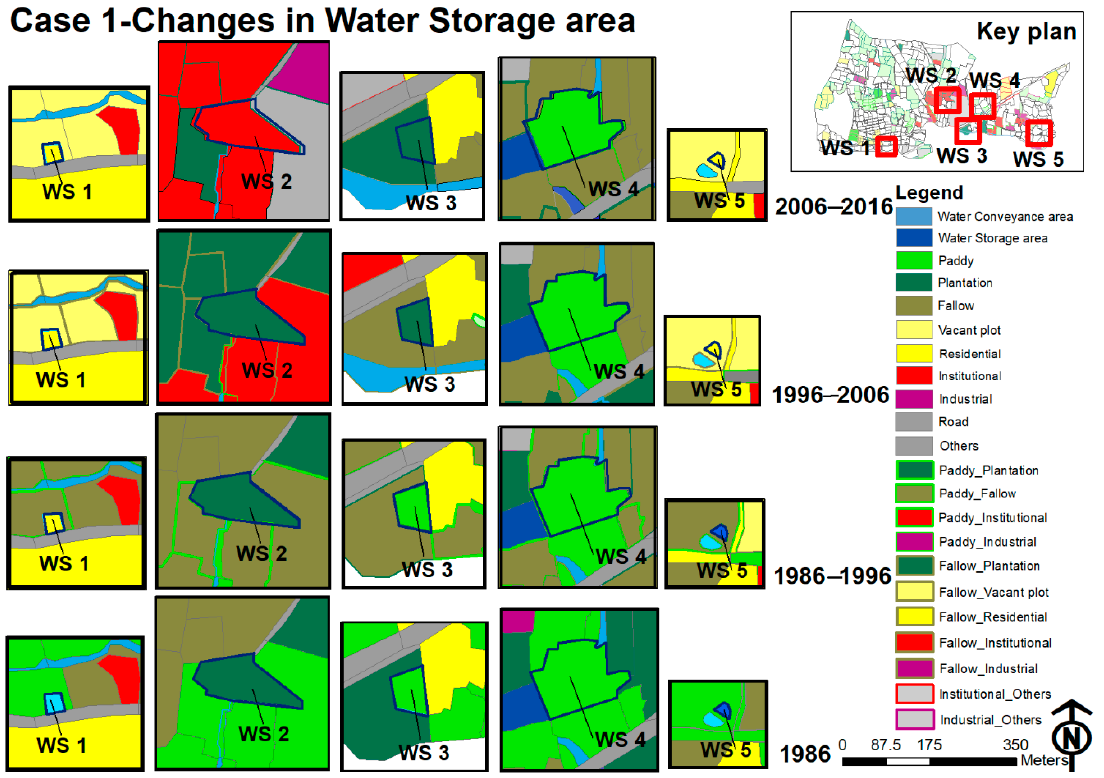
Figure 9. Trajectories of land use change: Case 1—water storage area.